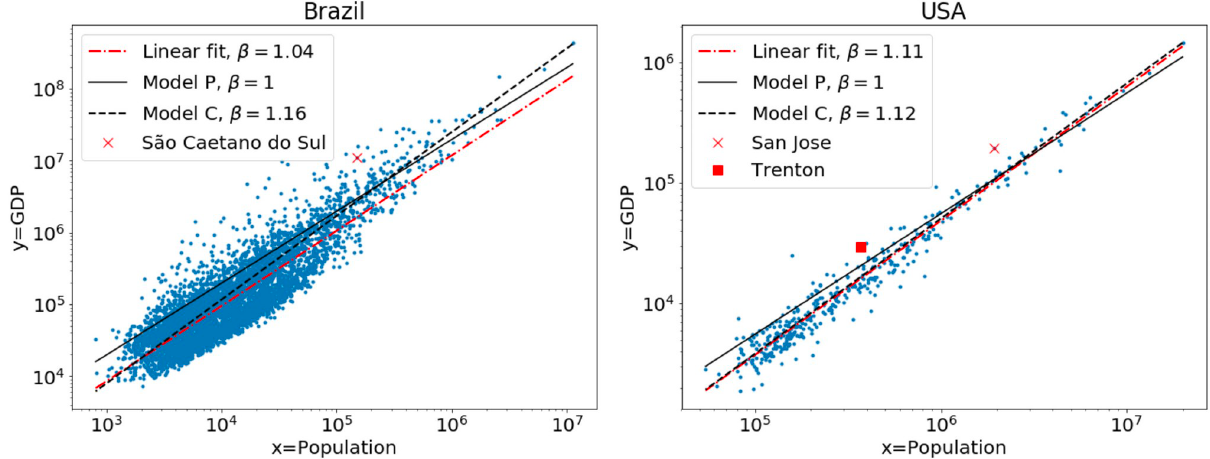
Fig 1. Urban scaling laws (1) based on different models. The GDP y of different municipalities in Brazil (left) and metropolitan areas in USA (right) are shown as a function of their population x . The straight lines correspond to different models: linear fit of the data, the Per capita model (P) and the City model (C), see Eq (11). The estimated scaling exponent β of the different models are shown in the caption. Cities close to large urban areas are highlighted. The City model gives more weight to larger cities and therefore leads to a value of β that is different from the linear fit [19].